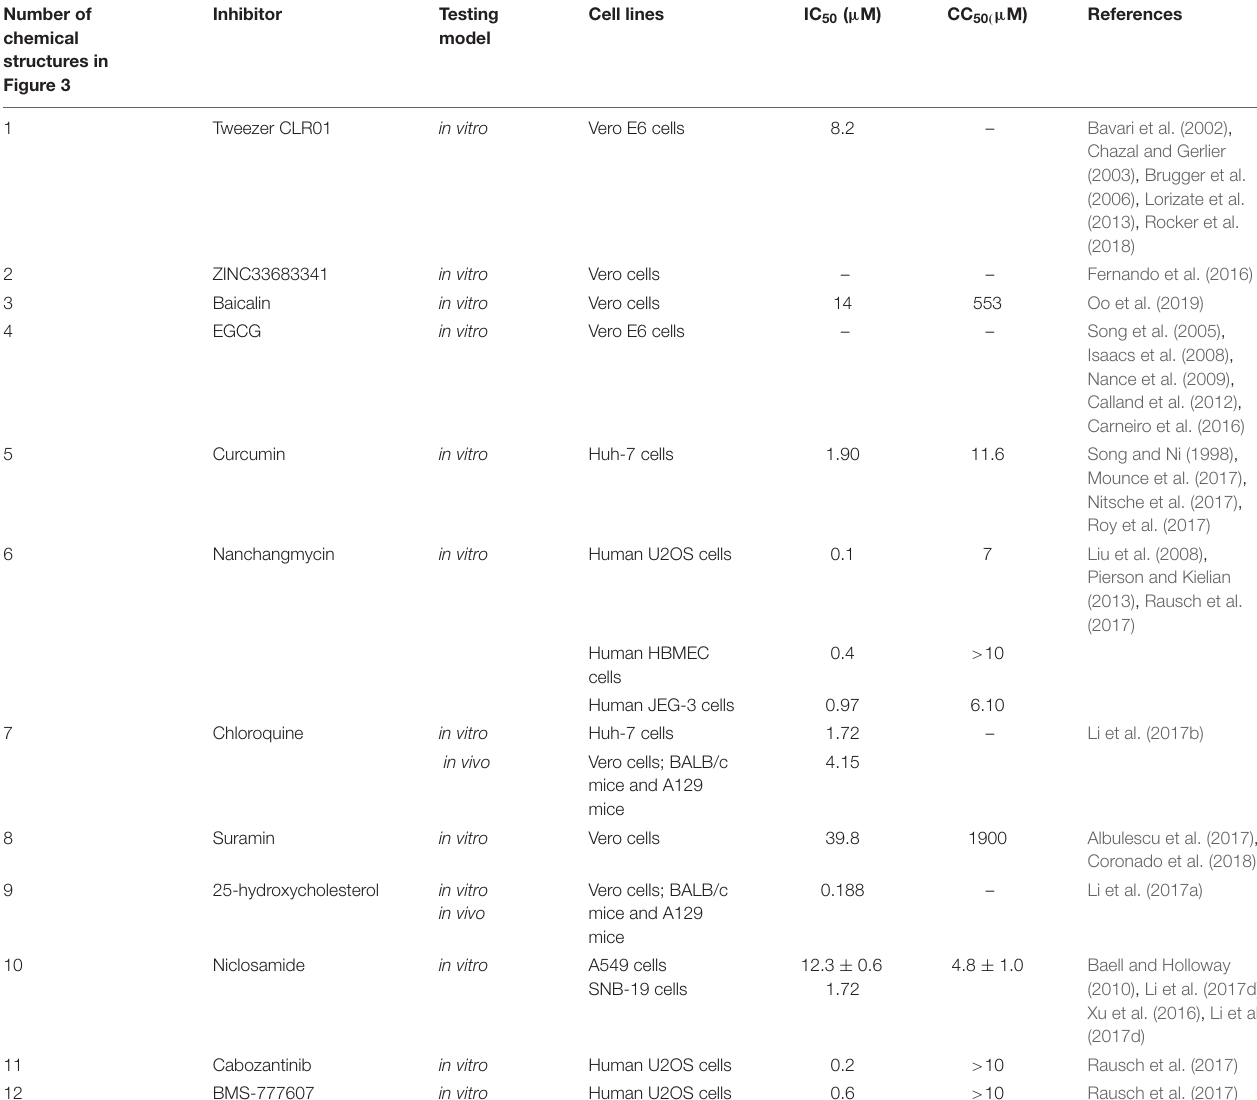
TABLE 2 | Zika virus entry inhibitors.